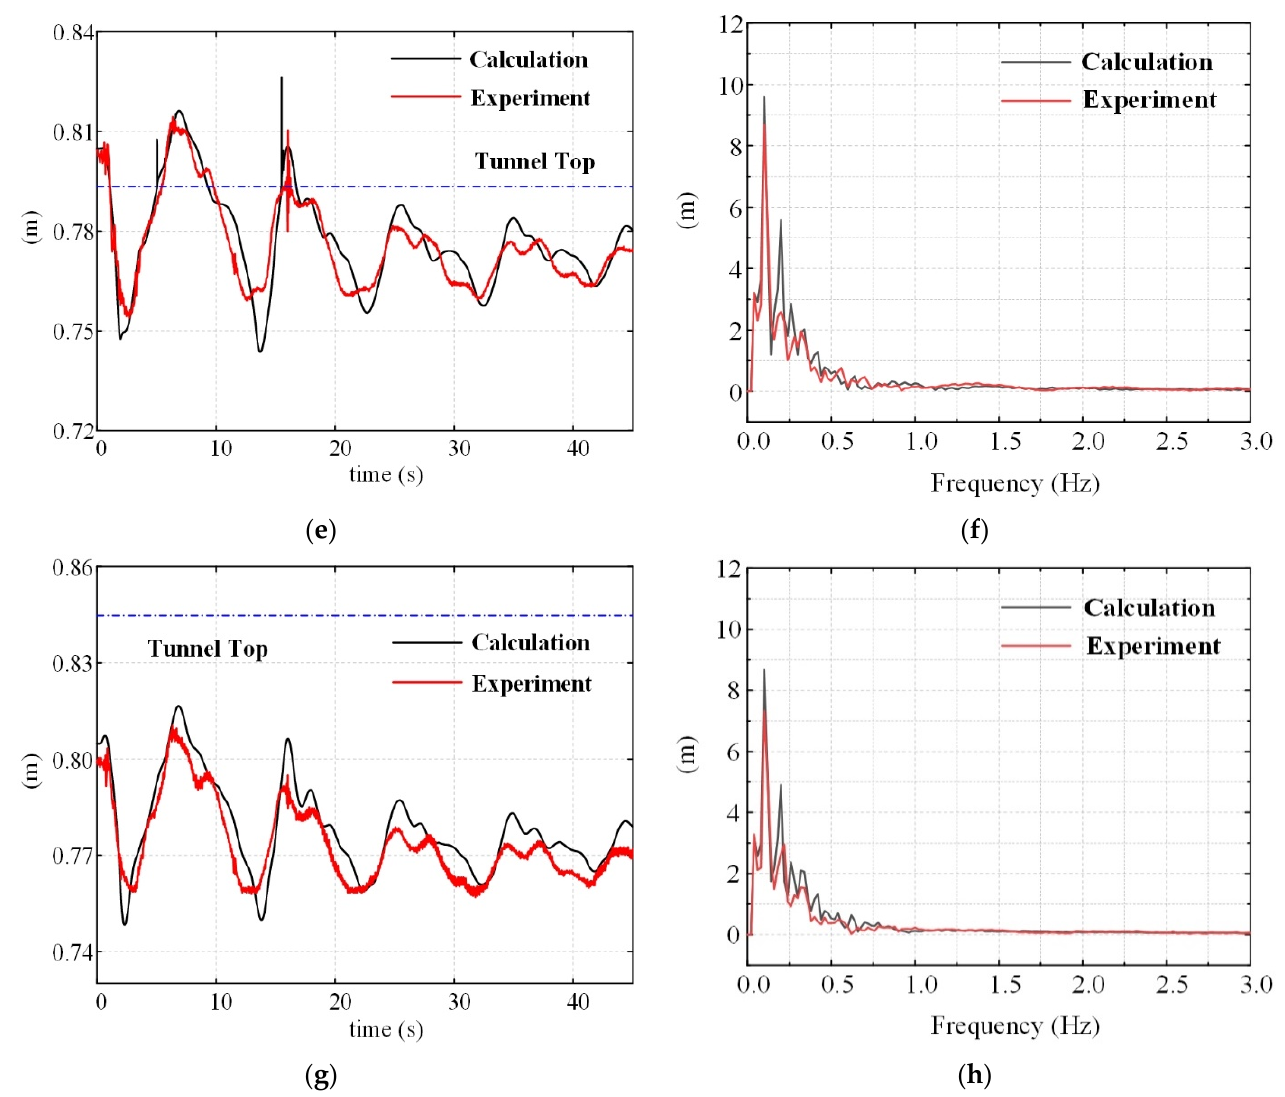
Figure 3. The curve of the stage (pressure) in the tailrace tunnel, shown for ( a ) the time domain of point 1, ( b ) frequency domain of point 1, ( c ) time domain of point 2, ( d ) frequency domain of point 2, ( e ) time domain of point 3, ( f ) frequency domain of point 3, ( g ) time domain of point 4, and ( h ) frequency domain of point 4.